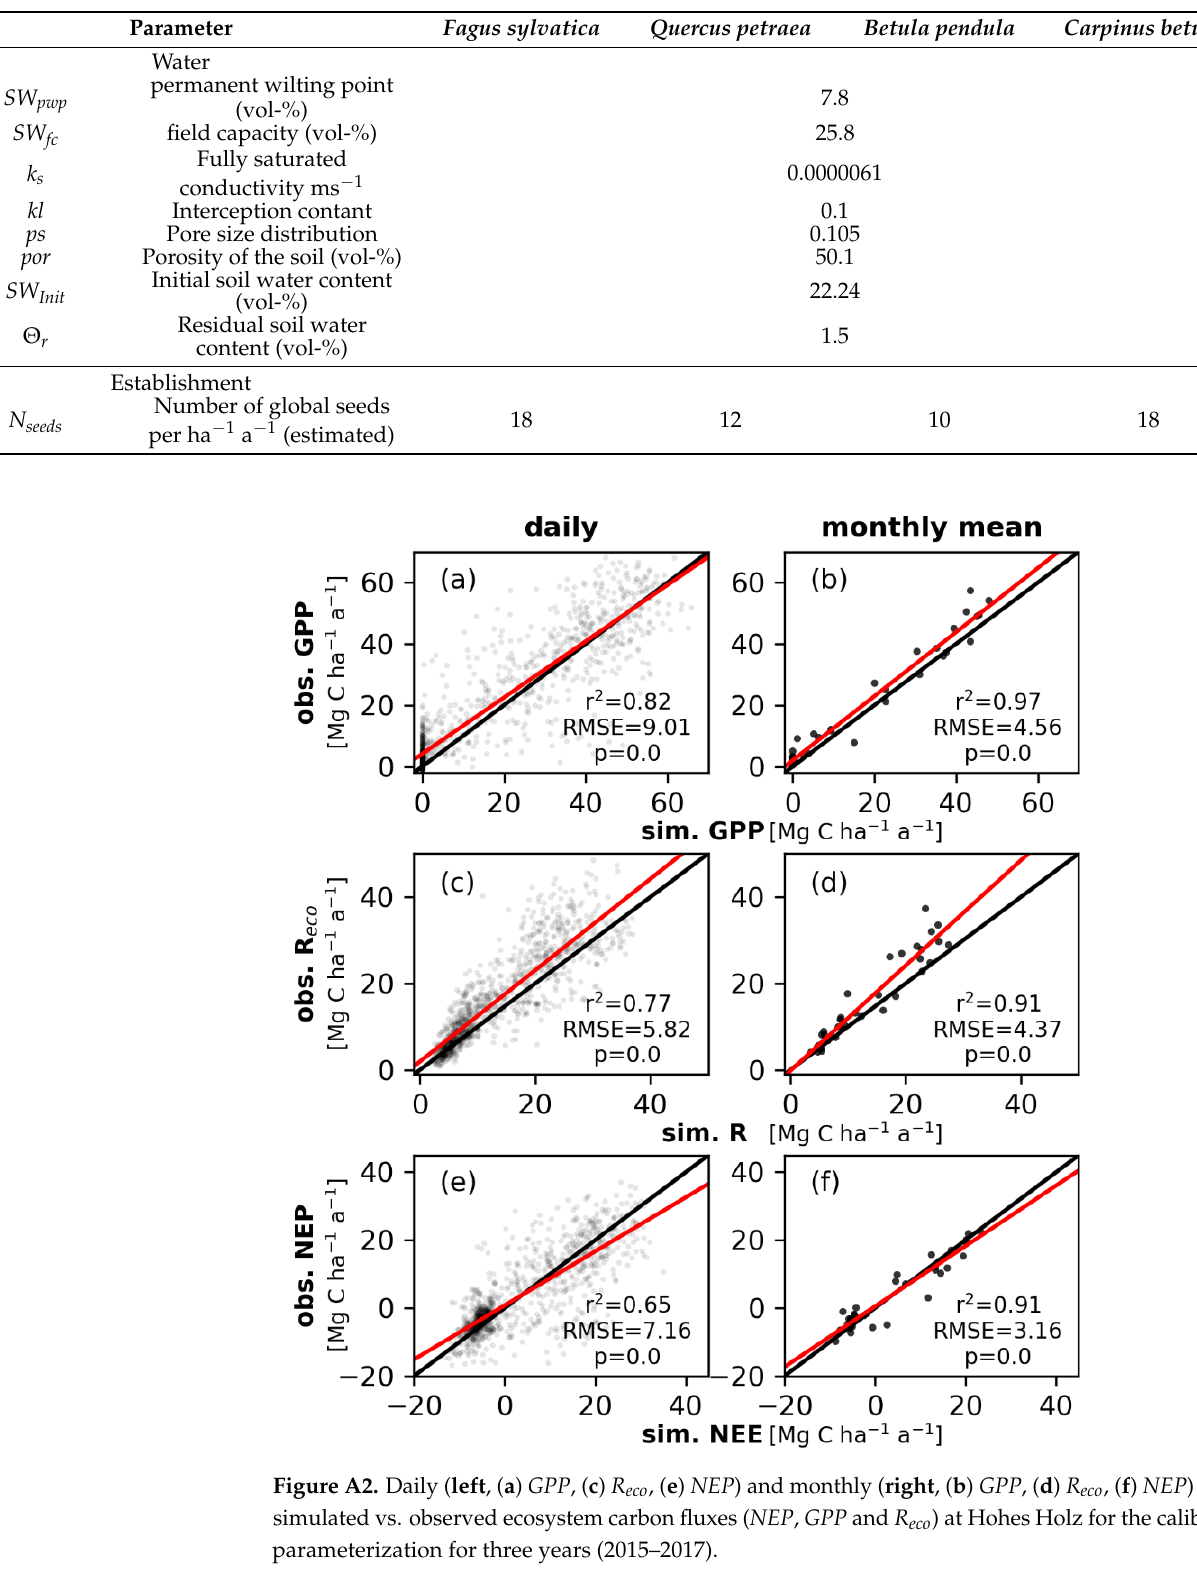
Table A3. Summary of the species-specific parameters taken from Bohn (2014) [30]. Parameter